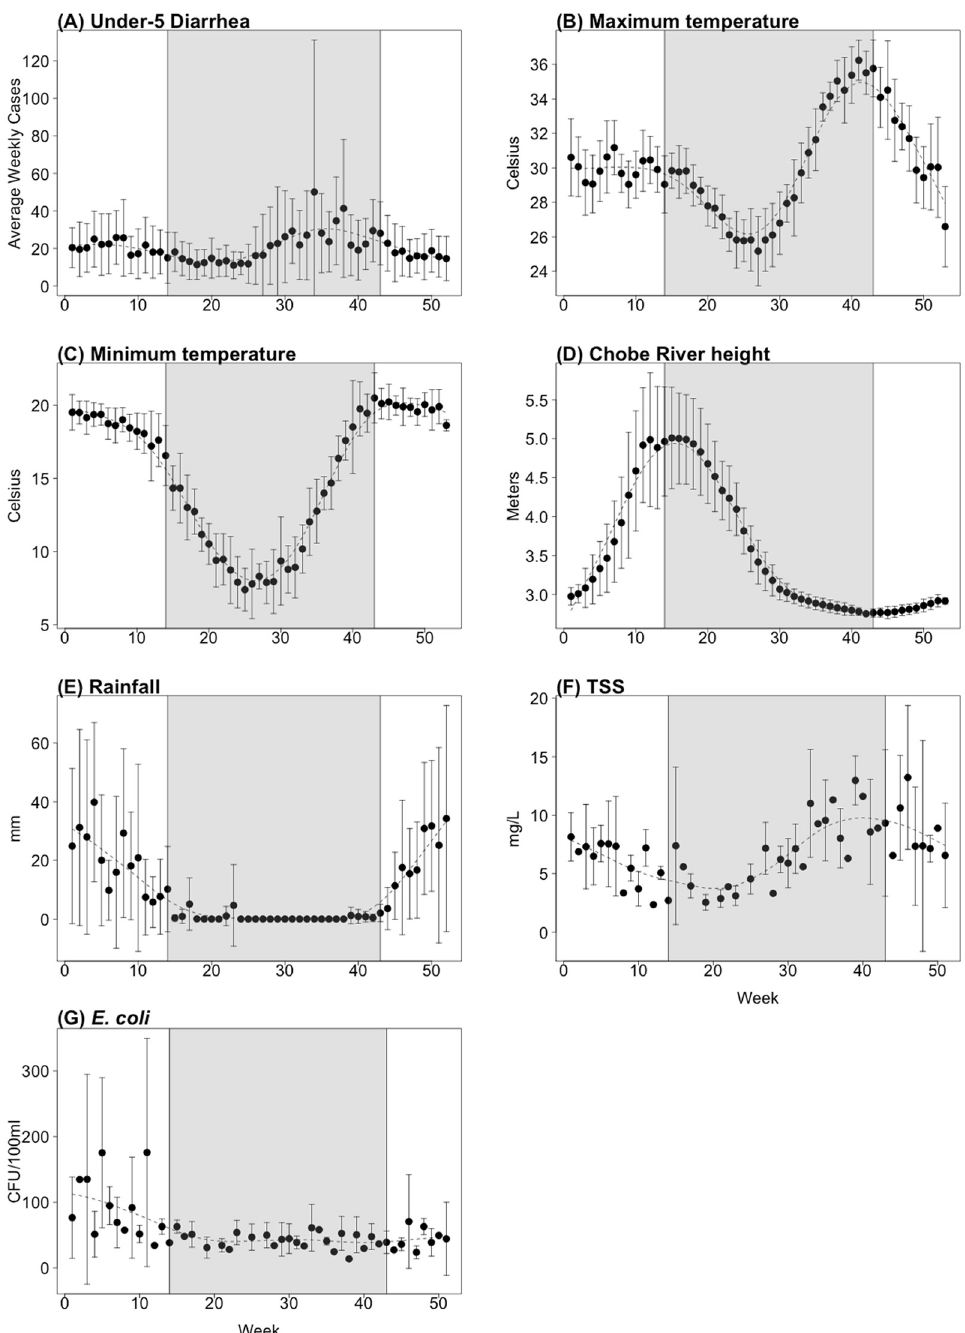
Fig 2. Seasonal plots of all variables. All plots represent the average weekly values across all years of data. The shaded portion represents the dry season, and the dashed black line is a cubic spline fit through the data to show seasonal trend. Average weekly number of under-5 diarrheal cases reported for 2007–2017 is shown in (A); (B—E) provide the average weekly values for environmental variables over the study period from January 2007 to June 2017 (full time series data are provided in S1 Fig), and (F) and (G) are average biweekly water quality measurements in the Chobe River for 2011–2017. CFU, colony-forming units; TSS, total suspended solids.